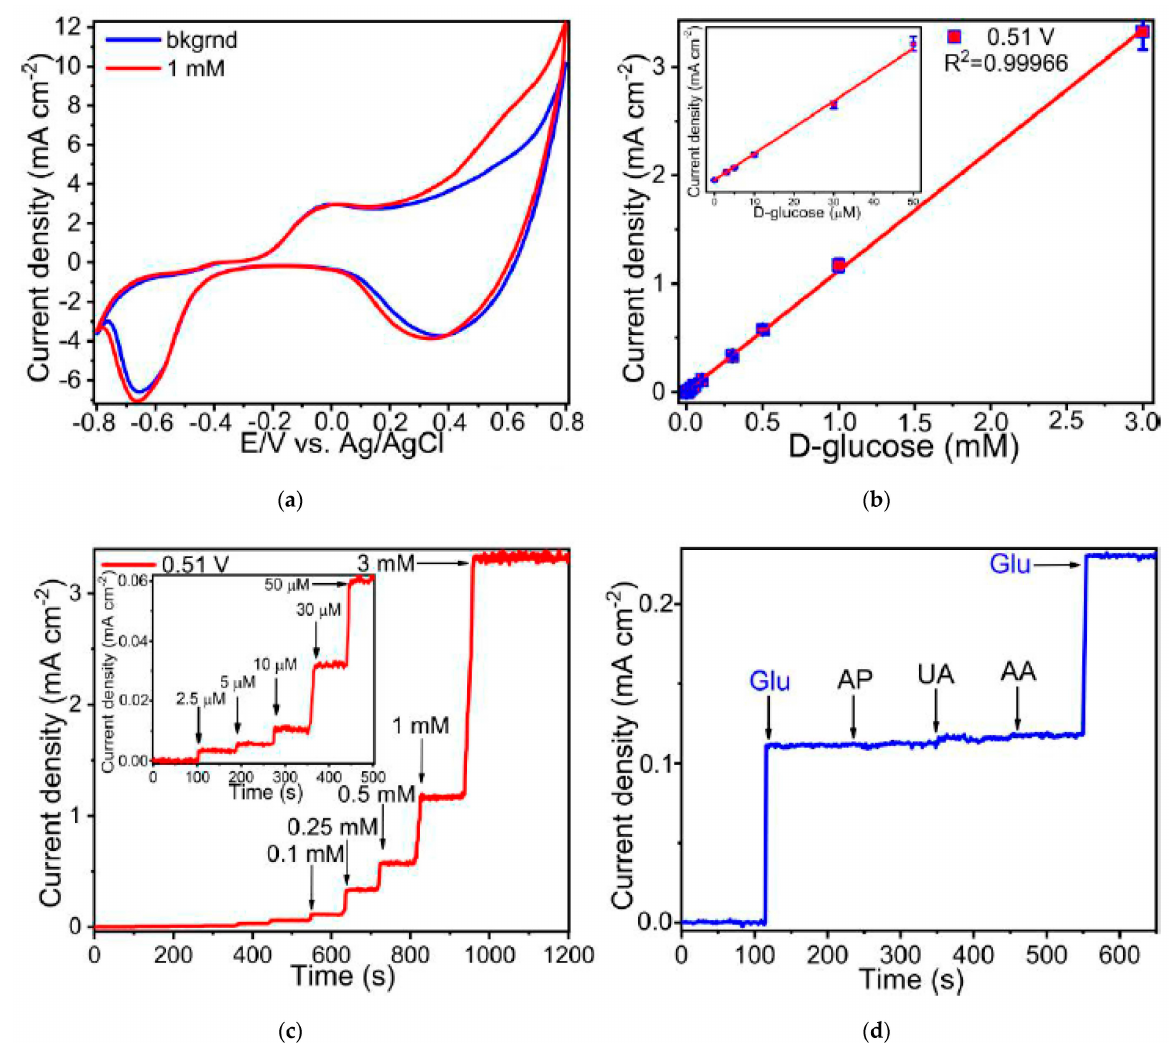
Figure 6. ( a ) Cyclic voltammograms of Cu patterns (electrode) measured in the solution of 0.1 M NaOH with addition of 1 mM D-glucose; ( b ) Amperogram of Cu electrode recorded at potential of 0.51 V in 0.1 M NaOH solution containing of D-glucose of various concentration; ( c ) Linear range of D-glucose concentrations for enzyme-less sensing using the fabricated Cu electrode; ( d ) Selectivity of Cu electrode towards 100 µ M D-glucose (Glu) detection in the presence of 20 µ M 4-acetamidophenol (AP), 20 µ M uric acid (UA) and 20 µ M ascorbic acid (AA) observed in the background solution of 0.1 M NaOH. In these experiments, we used Cu electrodes sintered on